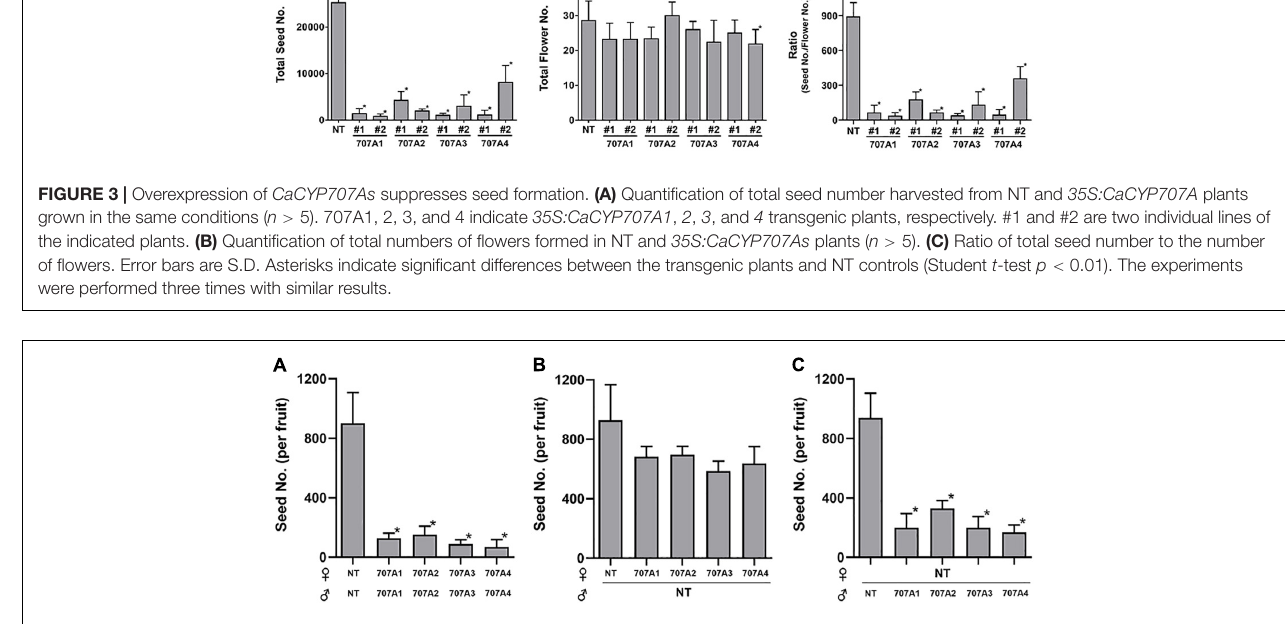
FIGURE 4 | Cross-pollination rescues defective seed formation in CaCYP707A -overexpressing plants. (A) The number of seeds were quantified in the NT and transgenic fruits generated by self-pollination ( n > 5). (B) The number of seeds were quantified in the 35S:CaCYP707As transgenic fruits generated by cross-pollination using NT pollens ( n > 5). (C) The number of seeds were quantified in the NT fruits generated by cross-pollination using the pollens of 35S:CaCYP707As transgenic plants ( n > 15). NT, 707A1, 2, 3, and 4 indicate non-transgenic, 35S:CaCYP707A1, 2, 3 , and 4 , respectively. Error bars are S.D. Asterisks indicate significant differences between NT control and the indicated samples (Student t -test, p < 0.01). Experiment (A,B) were performed three times with similar